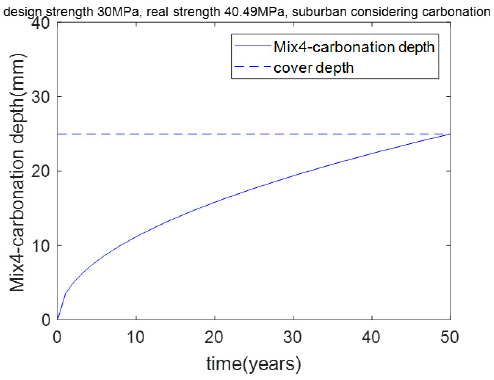
Figure 8. Carbonation depth of Mix4 concrete in a suburban region considering carbonation.